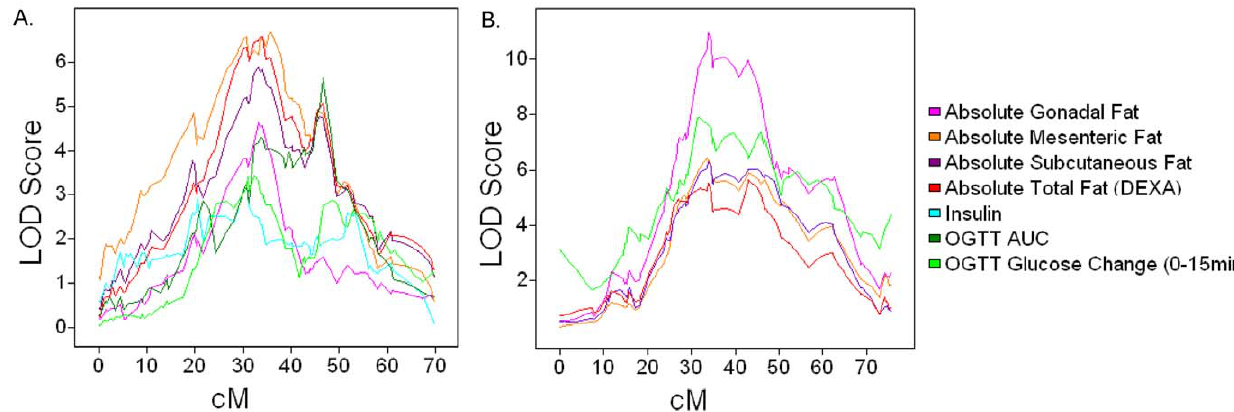
Figure 1. QTL hotspots for body composition, insulin, and glucose traits on chromosomes 6 and 8. QTL plots for traits mapping to chromosome 6 (A) and chromosome 8 (B) indicate that shared DNA variation likely drives multiple metabolic phenotypes on the respective chromosomes. For clarity not all significant QTL mapping to these loci are shown (see Table 1).